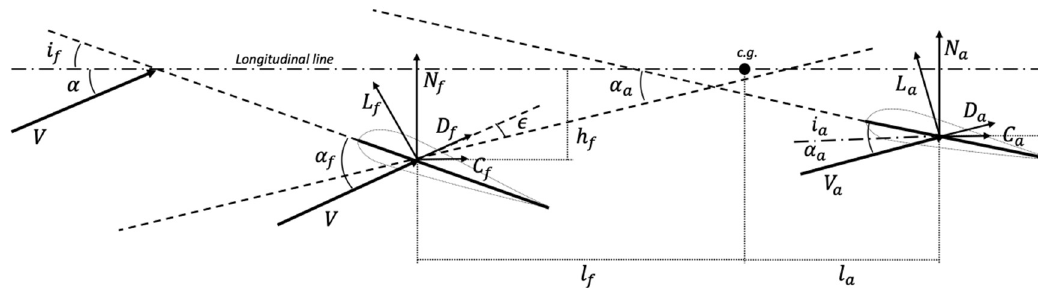
Figure 1. Longitudinal forces scheme.